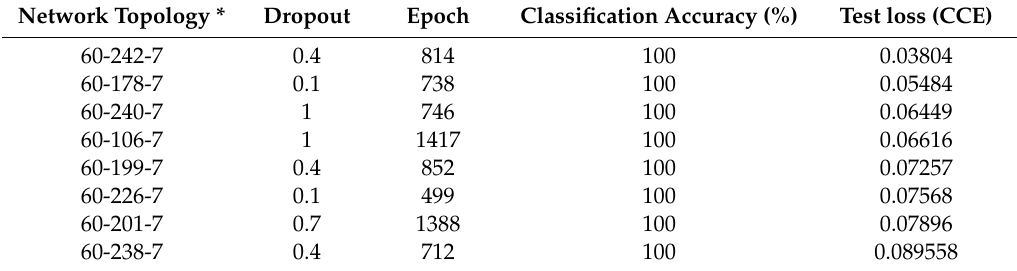
Table 2. The most e ffi cient 8 networks selected from 2000 networks based on classification accuracy and test loss.